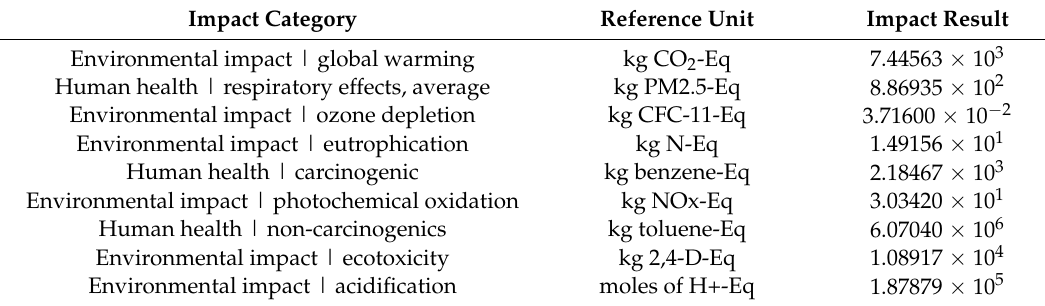
Table 4. LCIA results of nano-silica-modified asphalt mixtures per